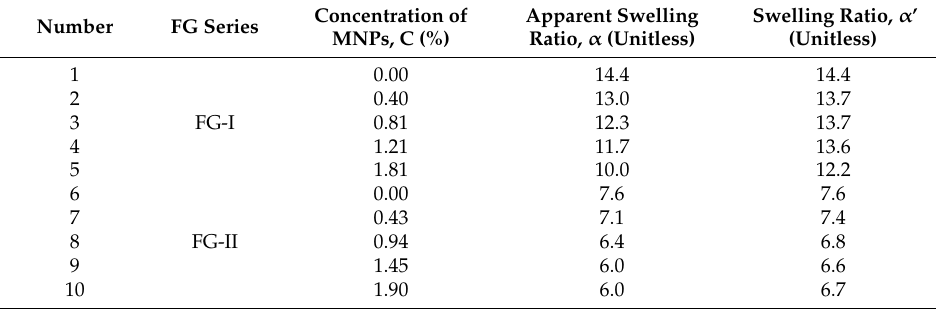
Table 1. Composition and swelling ratio of